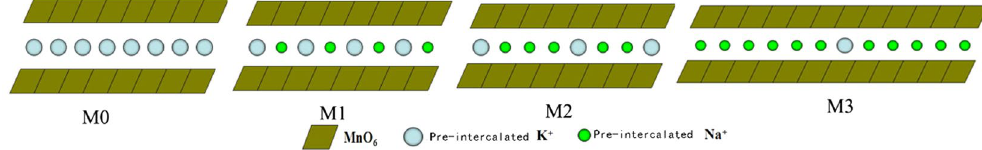
Figure 6. Schematic diagram of manganese oxides with different ratios of pre-intercalated Na